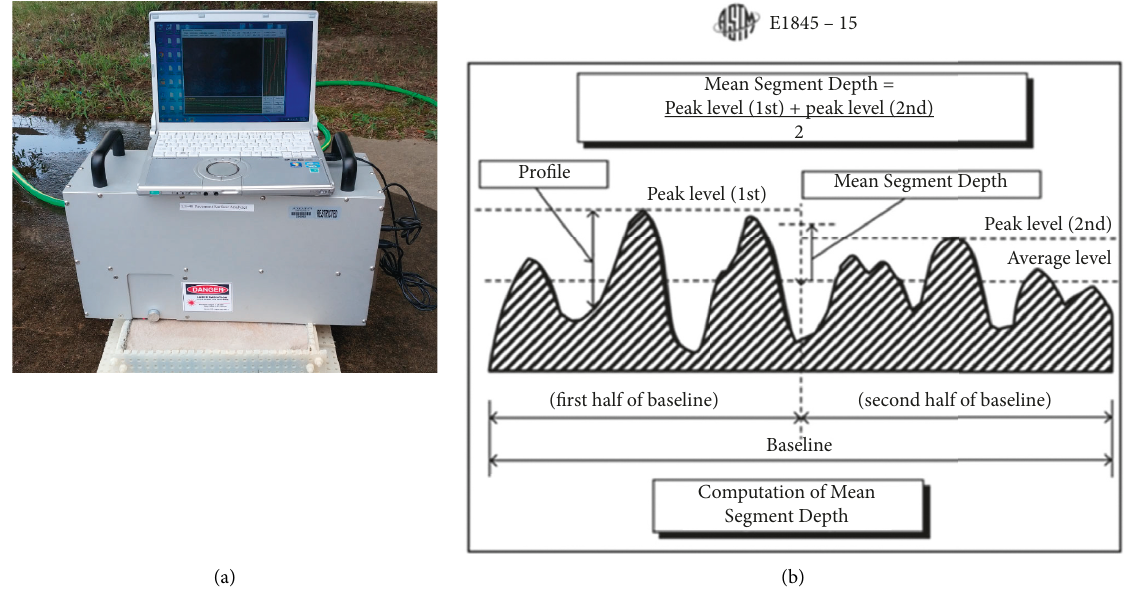
Figure 8: Surface analysis: (a) photograph of LS-40 Portable 3D Surface Analyzer and (b) computation procedure of mean segment depth (ASTM E1845).